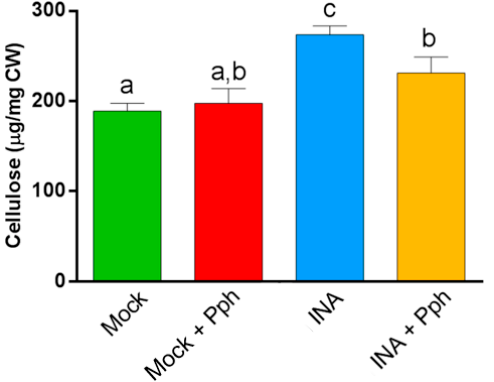
Figure 4. Cellulose content ( µ g per mg of dry weight CW) of the indicated treatments. Data represent mean ± SE ( n = 3). Statistical analysis was carried out by one-way ANOVA where letters indicate differences by Tukey test ( p < 0.05).